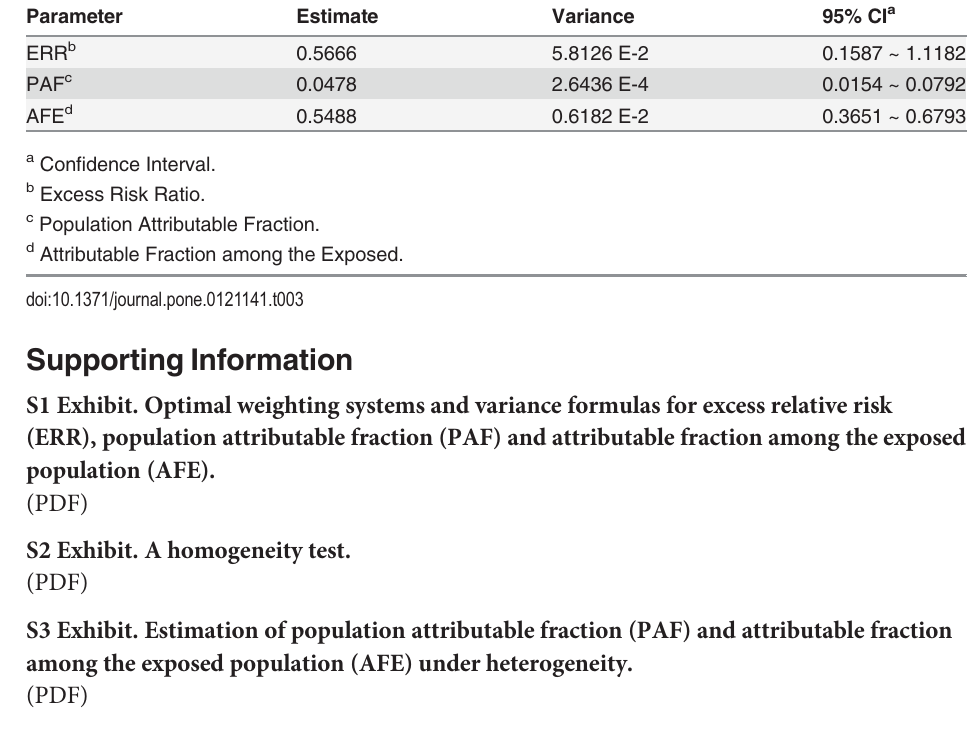
Table 3. Results for the analysis of the data in Table 1.